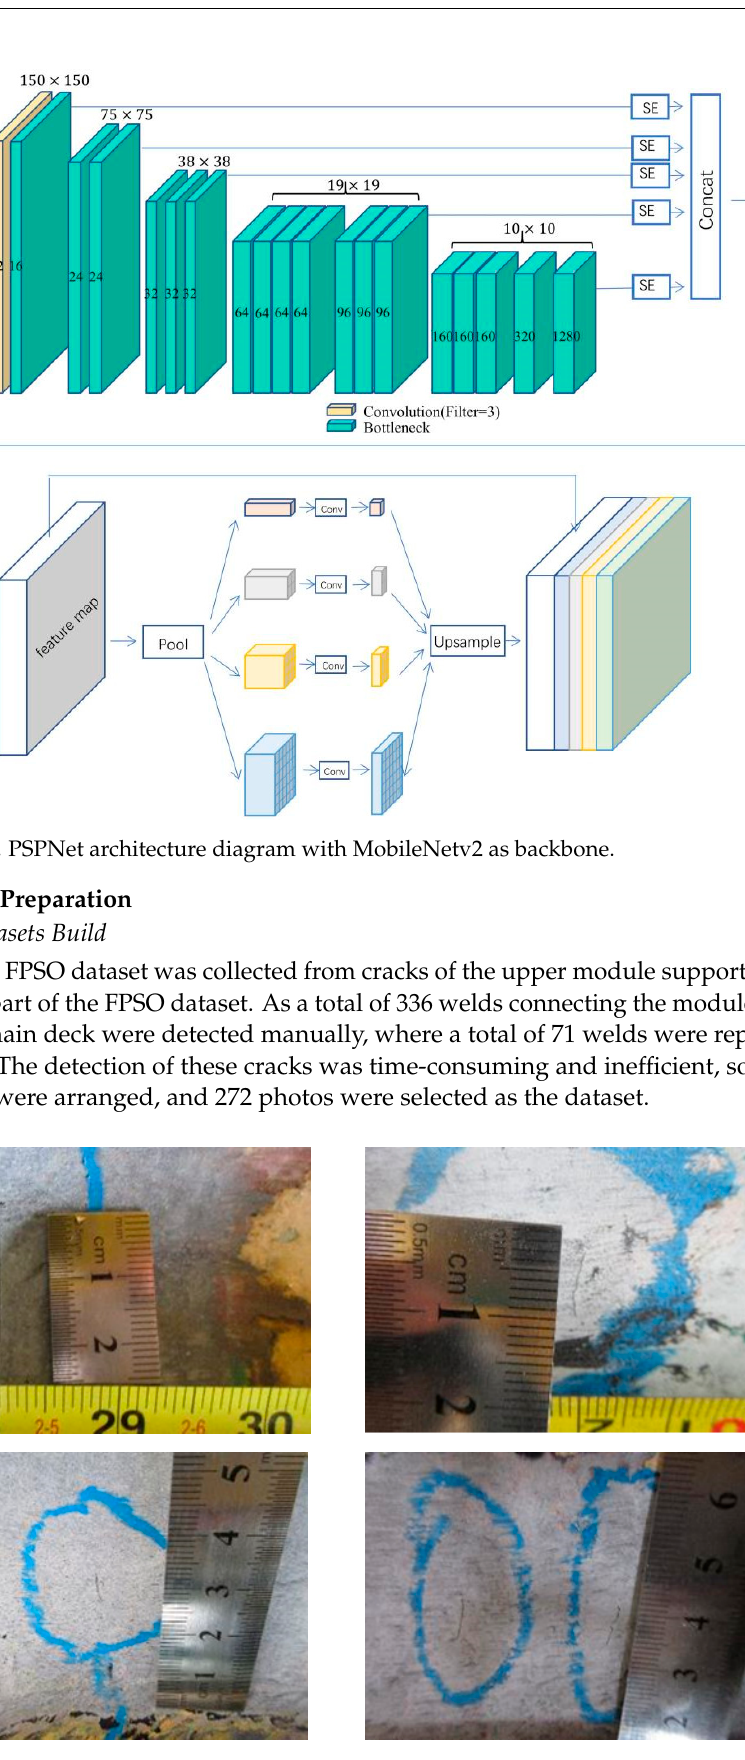
Figure 9. FPSO datasets.